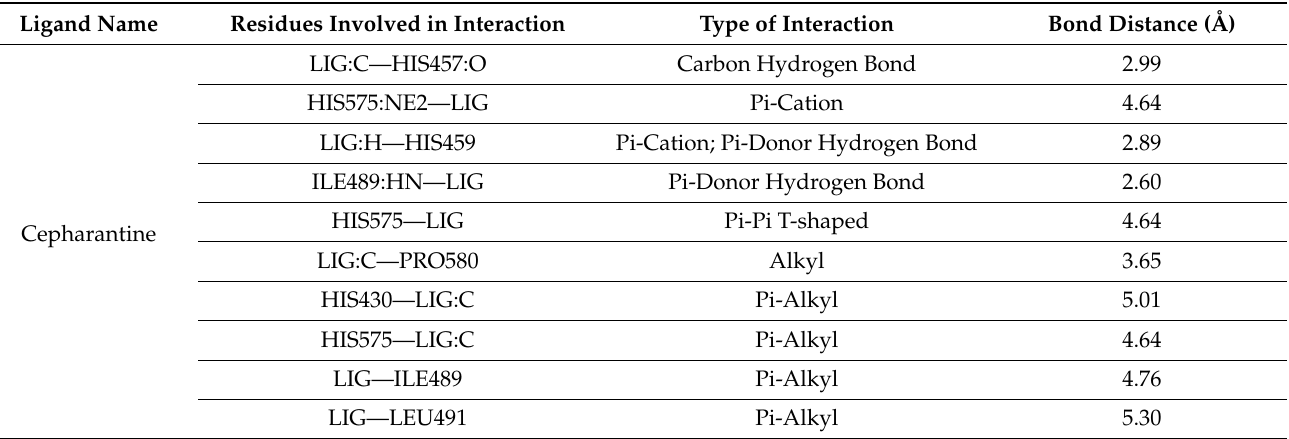
Table 3. Root mean square deviation and root mean square fluctuation for the top two complexes subjected to molecular dynamic simulation analysis. Parameters